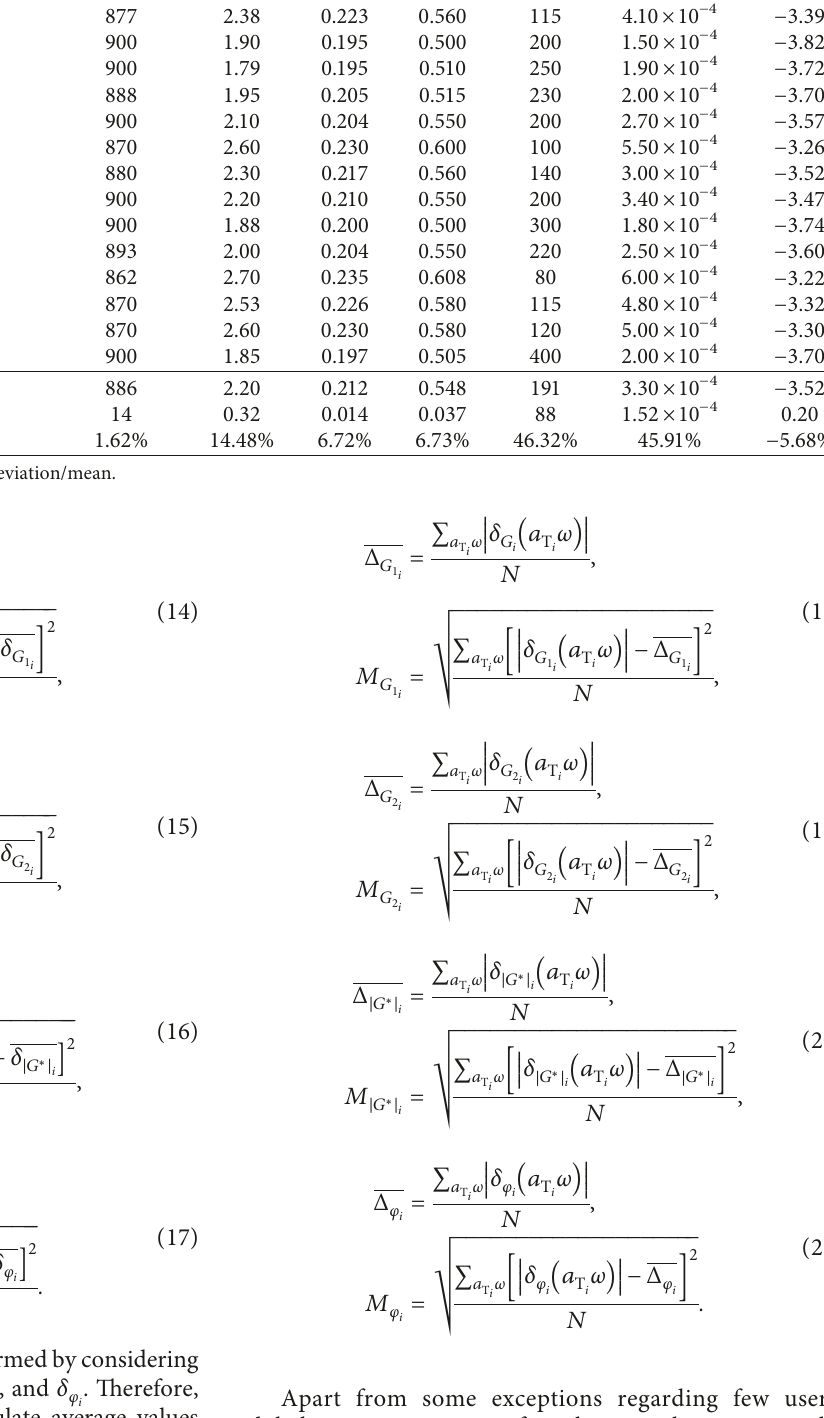
Table 1: WLF and 2S2P1D constants obtained for the bitumen by all the users of the calibration panel ( T C ( − ) C ( ° 1 2